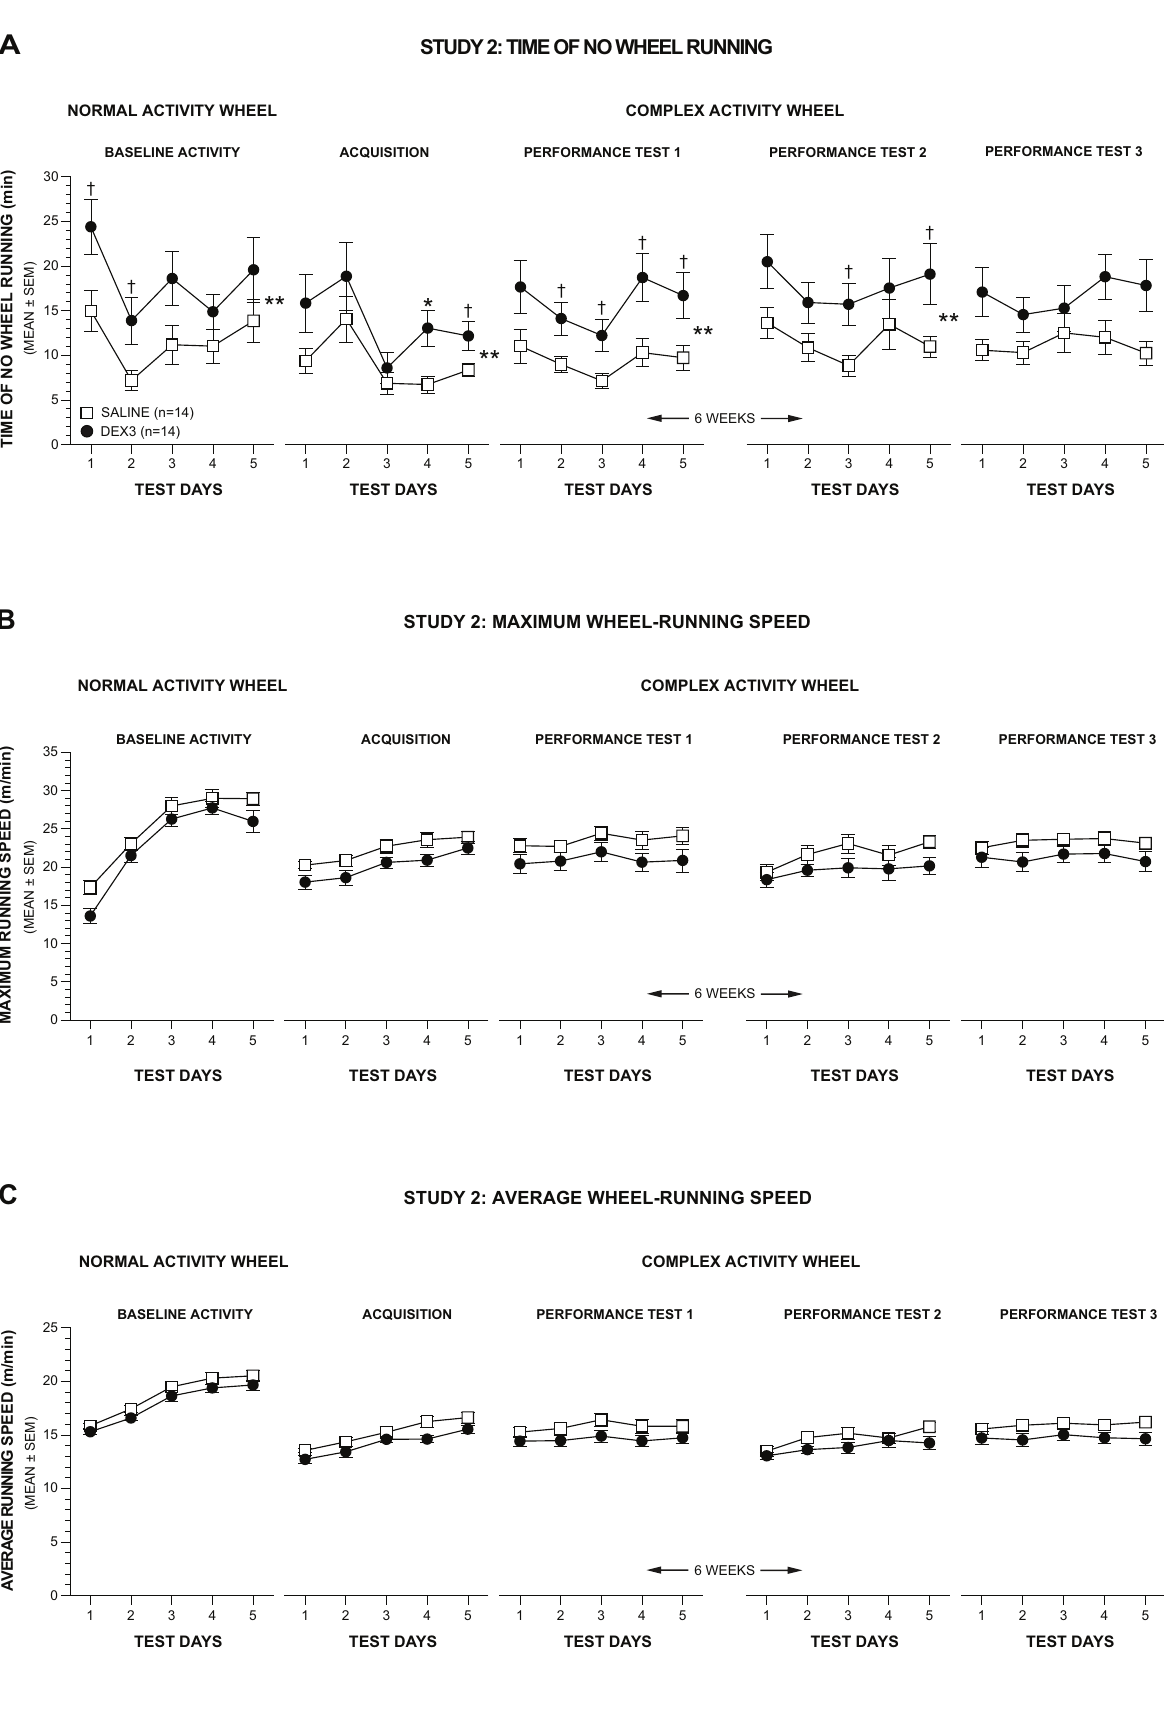
STUDY 2: TIME OF NO WHEEL RUNNING